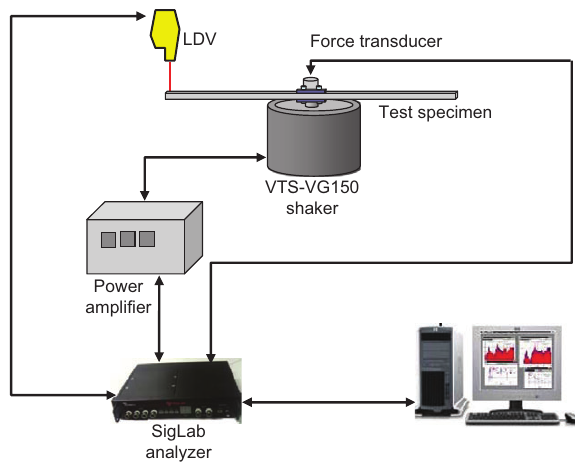
Figure 5 Optimized test FR7140 foam test specimen with meshing used for analysis.